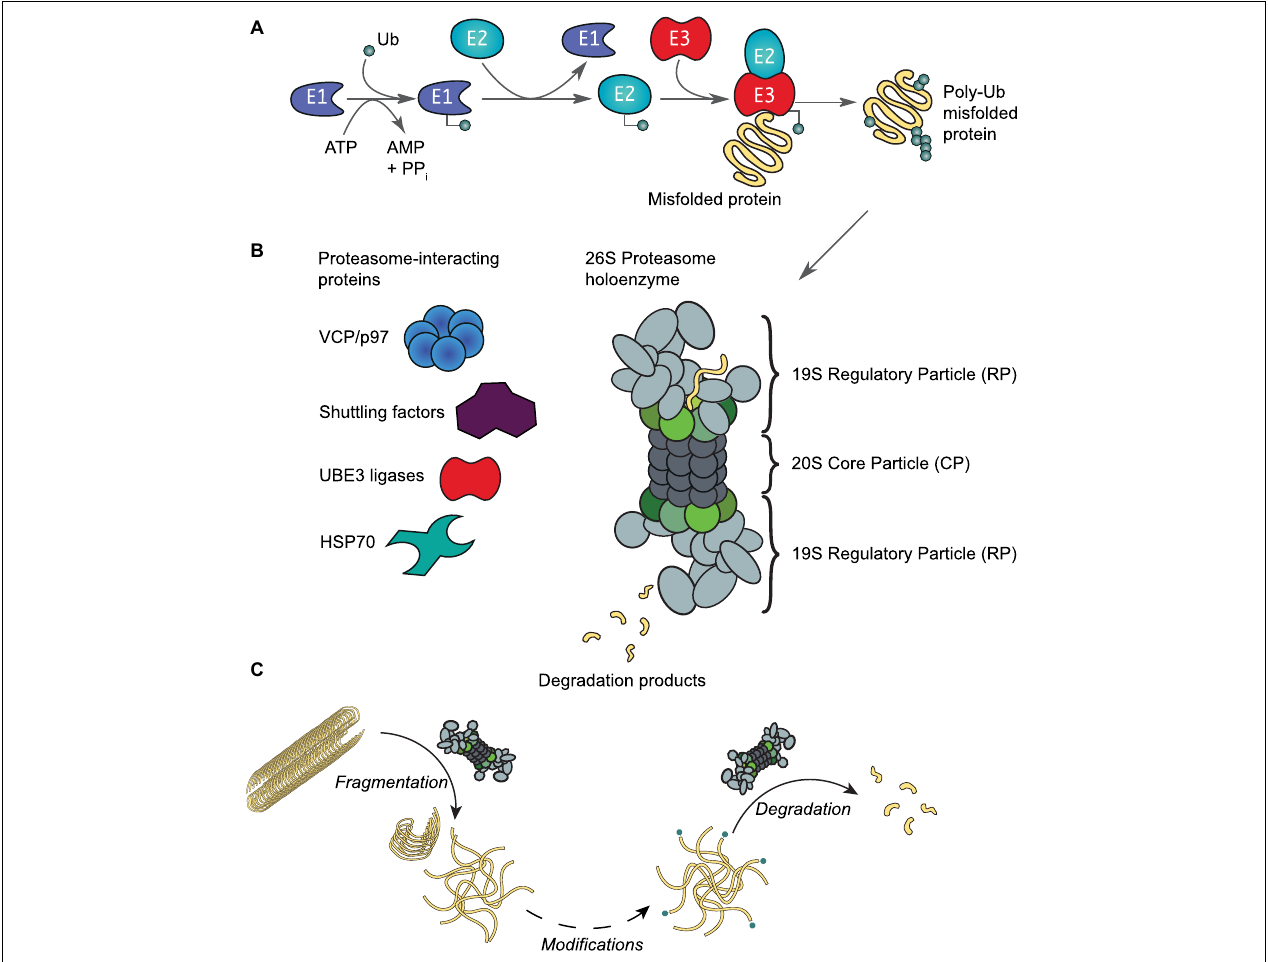
FIGURE 3 | The ubiquitin-proteasome system. (A) Protein ubiquitination is initiated by an E1 activating enzyme, which charges Ub to its active site cysteine residue in an ATP-dependent manner. This activated Ub is then transferred to the active site cysteine of an E2 conjugating enzyme, which with support from an E3 ligating enzyme, results in protein ubiquitination. Ubiquitinated proteins are recognized by proteasomes, leading to the unfolding and degradation of the substrate. (B) Schematic representation of the 26S proteasome holoenzyme. This enzyme complex consists of a 20S core particle (CP), capped by 19S regulatory particles (RP). Both the CP and RP may exist as free particles or assembled into a holoenzyme. Rpt1-6 of the RP are colored in shades of green as in Figure 2A . A number of proteins interact reversibly to assist with various proteasomal functions as required by the host cell. (C) In addition to protein degradation, the proteasome holoenzyme is also able to fragment stable fibrils into smaller fragments ( < 500 nm) such as oligomers (Cliffe et al., 2019); as well as capable of degrading oligomers that are ubiquitinated at their N-termini by e.g., UBE2W (Ye et al.,